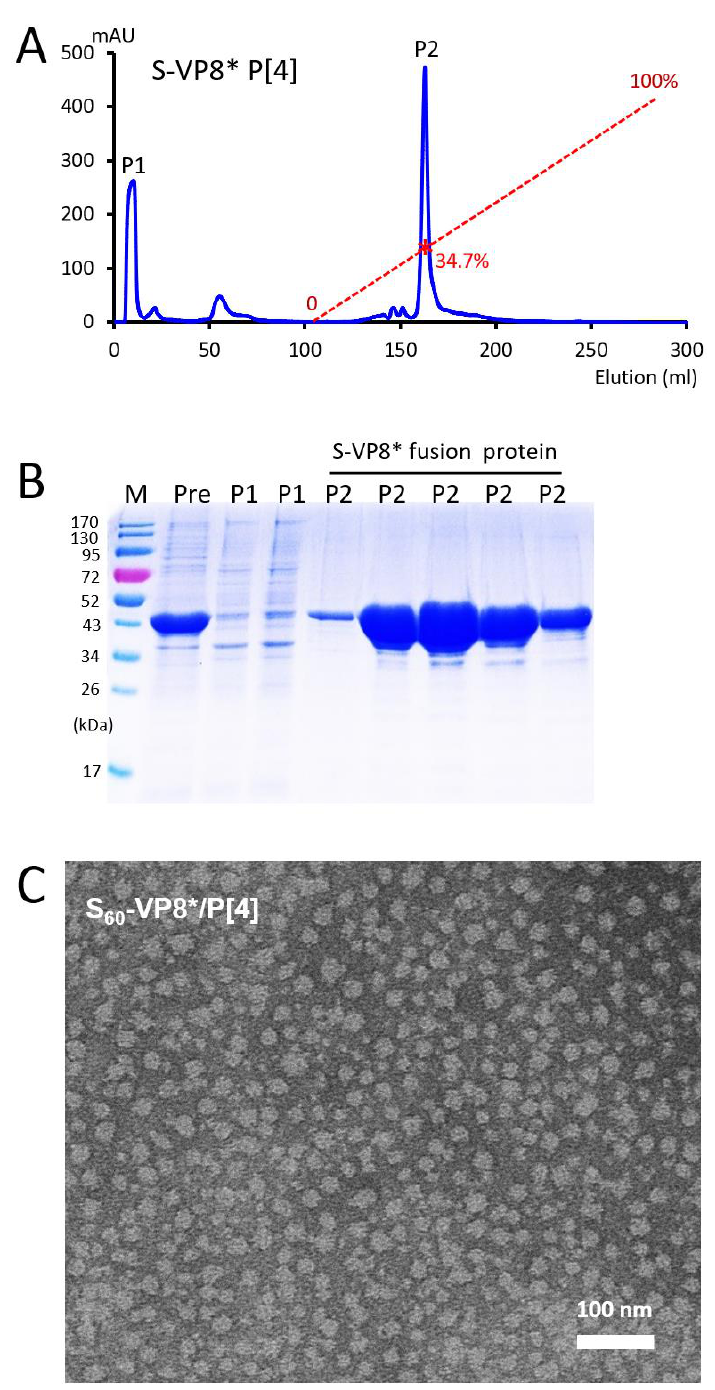
Figure 2. Purification of tag-free S-VP8* P[4] protein and its self-assembly into pseudovirus nanoparticles (PVNPs). ( A ) An anion exchange elution curve of the ammonium sulfate [(NH 4 ) 2 SO 4 ] precipitated S-VP8* P[4] protein. The X-axis indicates elution volume (mL), whereas the Y-axis shows UV (A 280 ) absorbances (mAU). The red dashed line indicates the linear increase of elution buffer B (0 – 100%), with a red star symbol indicating the percentage of buffer B at the elution peak of the S-VP8* P[4] protein (34.7%). Two major peaks that were analyzed by SDS-PAGE are indicated as P1 and P2. ( B ) SDS-PAGE of the pre-loaded protein (Pre), as well as proteins from peak 1 (P1) and peak 2 (P2) from the anion exchange chromatography. Pre is the (NH 4 ) 2 SO 4 precipitated protein samples before loading to the column; M is the pre-stained protein standards with indicated molecular weights in kDa. The S-VP8* P[4] protein was eluted in P2. ( C ) A micrograph of negative-staining transmission electron microscopy (TEM) of the protein from P2 shows spheric-shaped PVNPs.